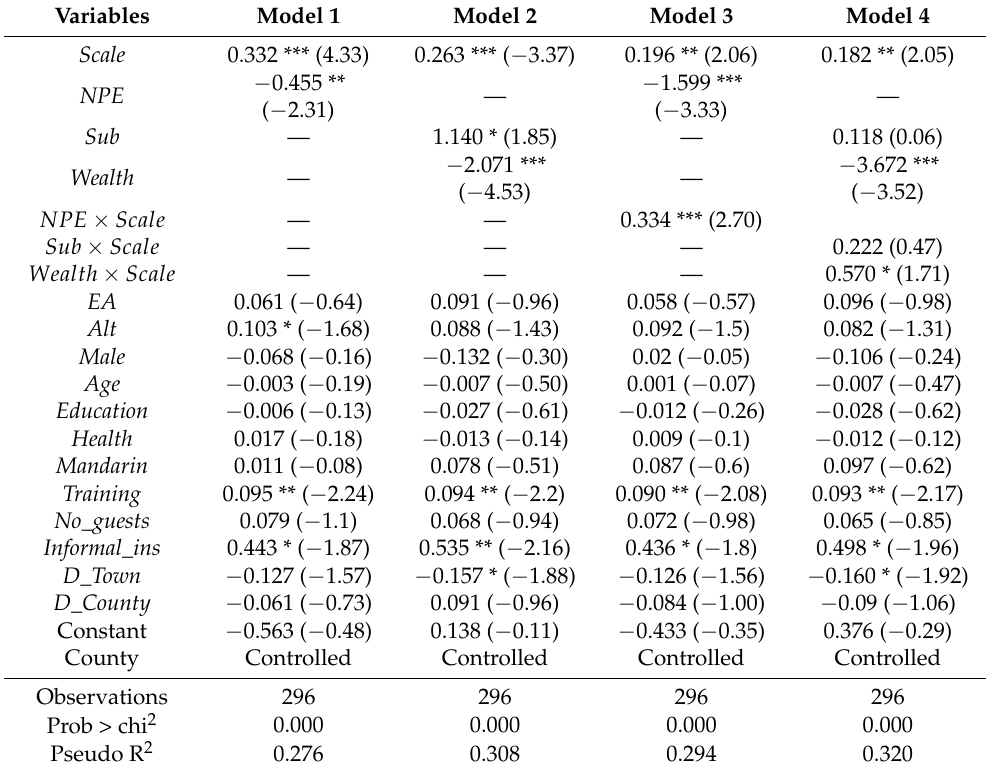
Table 2. Estimated model of the impact of Scale and NPE on